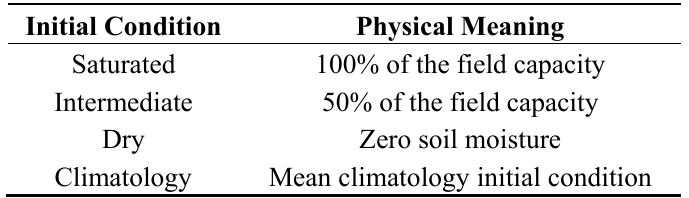
Table 3. Xinanjiang model soil moisture initial